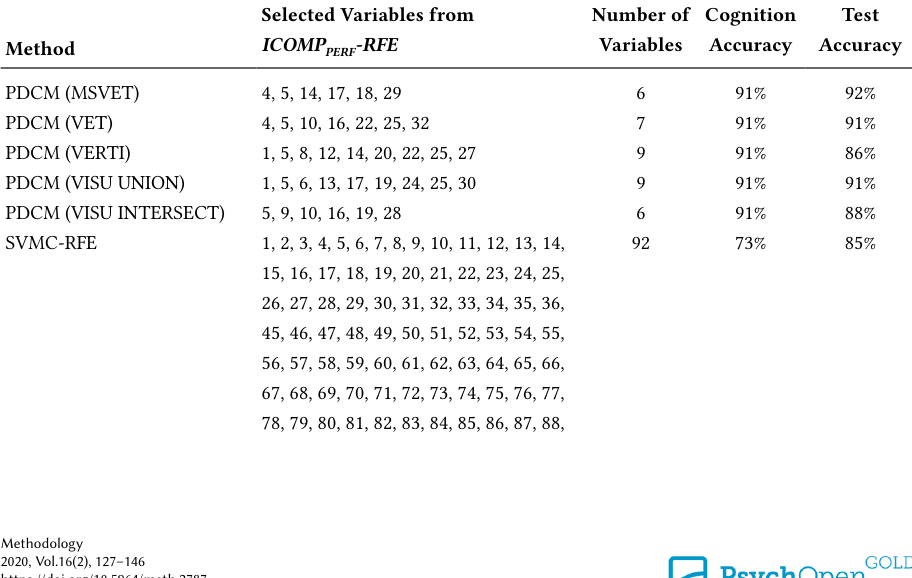
PDCM Versus Various Ranking Based Method Using Gaussian Kernel